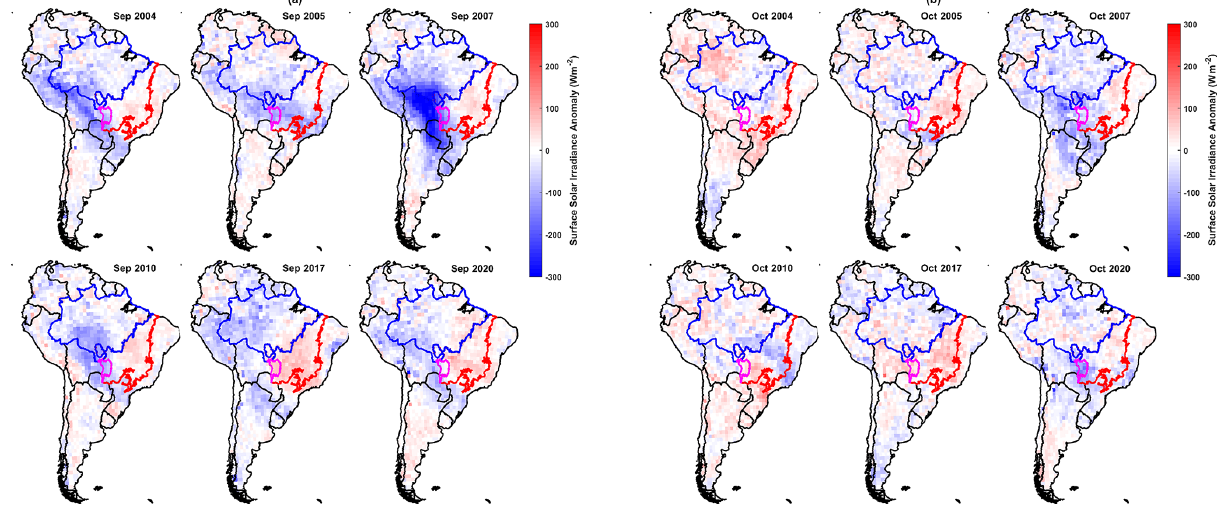
Figure 9. Spatial distribution of the mean surface solar irradiance under cloudless conditions and in the presence of aerosol for the months of September and October of different years. The biome borders are represented by the colors blue (Amazon Rainforest), red (Cerrado ecosystem), and magenta